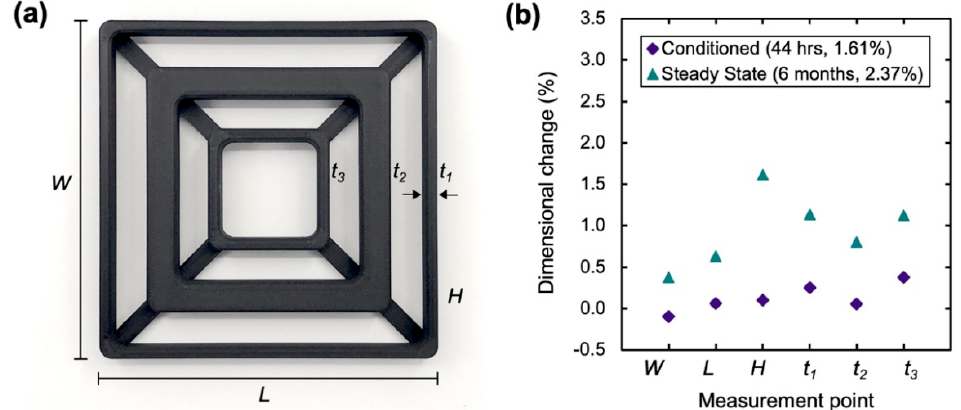
Figure 5. ( a ) Dimensional accuracy calibration part printed in Onyx with measurement points denoted. ( b ) Plot of moisture-induced swelling with respect to an Onyx dry state part. Values are the average of measurements taken from two independent samples and correspond to the labels in ( a ).